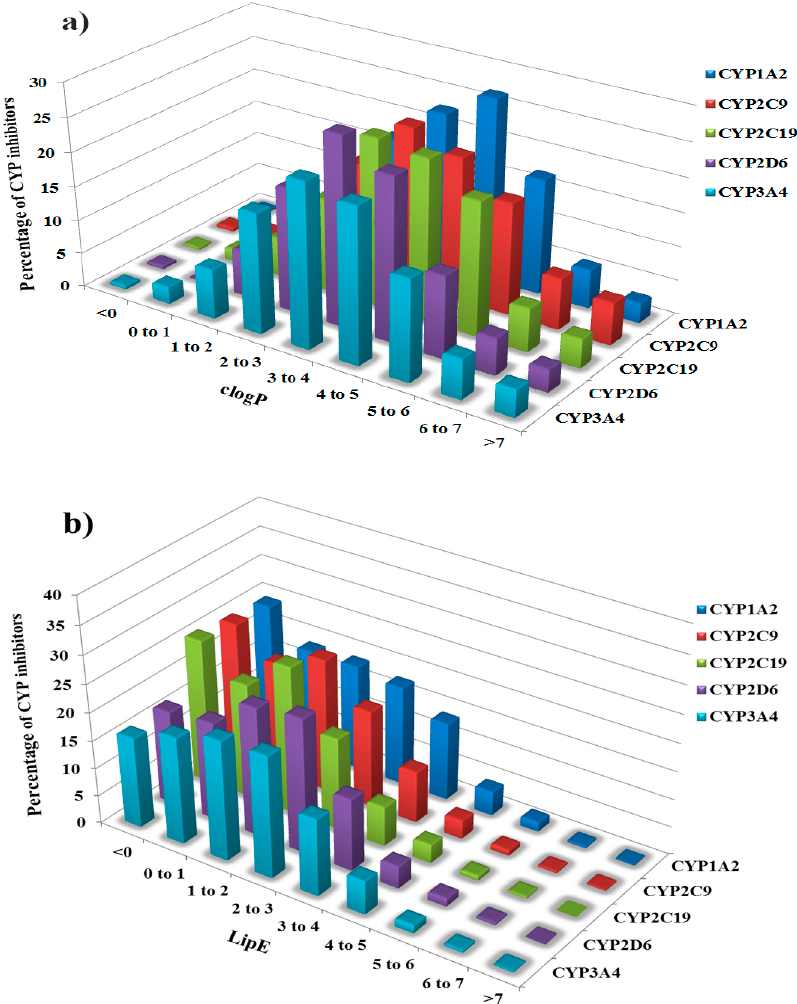
Figure 3. ( a ) Distribution of clogP and ( b ) Lipophilic efficiency (LipE) values for each class of P450 inhibitors (CYP1A2, CYP2C9, CYP2C19, CYP2D6 and Cytochrome P450 inhibitors (CYP1A2, CYP2C9, CYP2C19, CYP2D6 and CYP3A4).